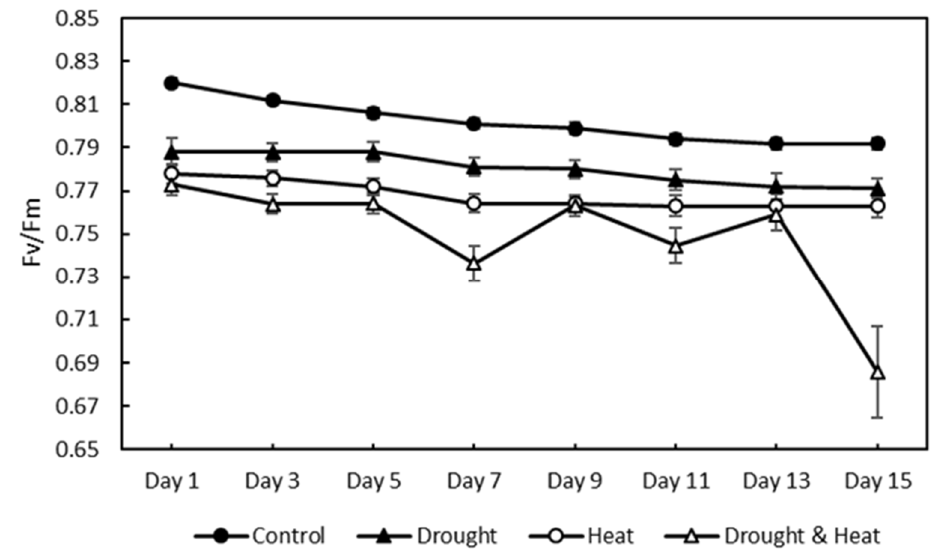
Figure 7. Effect of four treatments (control, drought, heat, and combination drought–heat stress) during 15 days of observation on the maximum quantum efficiency of photochemistry ( Fv/Fm ) value using the developed CFI system. The vertical bar represents the standard error (SE) for 30 replications.